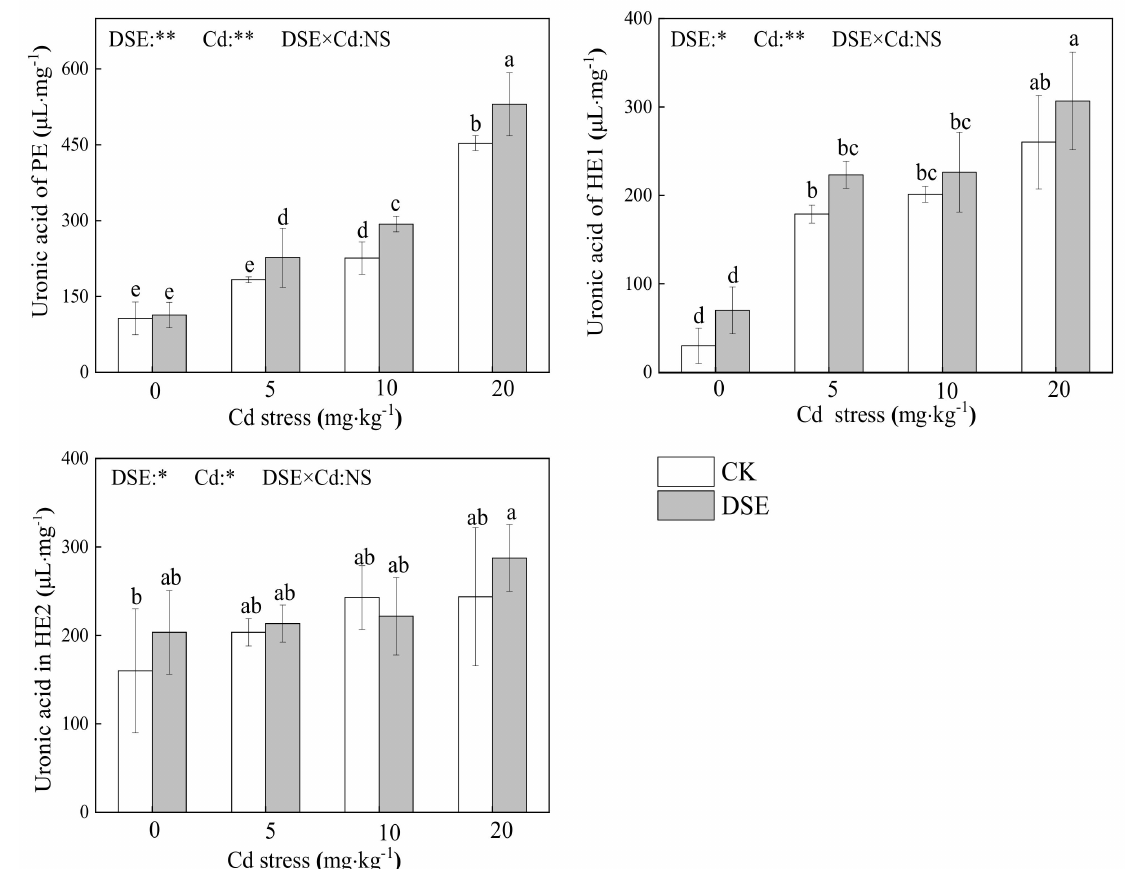
Figure 4. Uronic acid content in pectin (PE), hemicellulose–1 (HE1), and hemicellulose–2 (HE2) of the RCW of inoculated DSE maize with different Cd stress. Error bar indicates standard deviation. Cd: cadmium treatment; CK: the control of non-inoculation; DSE: Exophiala pisciphila inoculation; different little letters refer to p < 0.05 according to the LSD test. “NS”, “*”, and “**” mean no significance, p < 0.05 and p < 0.01 according to two-way ANOVA,